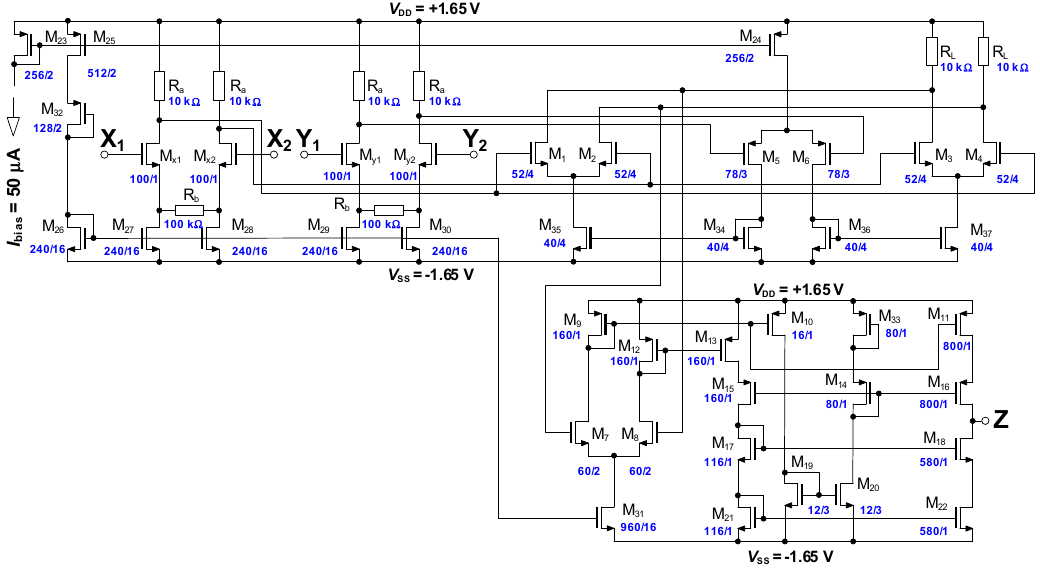
Figure A2. Full CMOS topology of the voltage multiplier with current output (CMOS MLT).